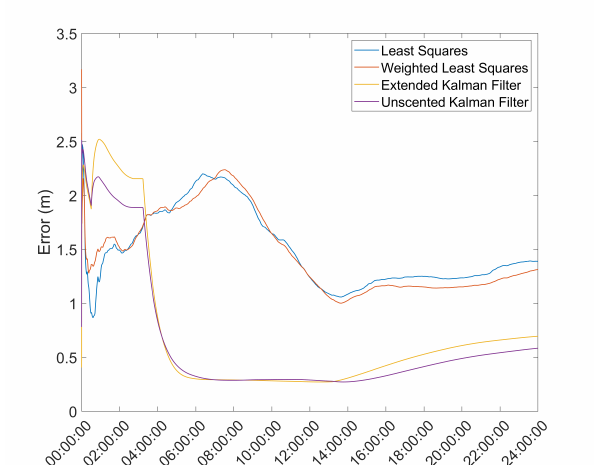
Figure 10. Mean error for 24 h position survey of the reference station antenna using the finalized position methods.